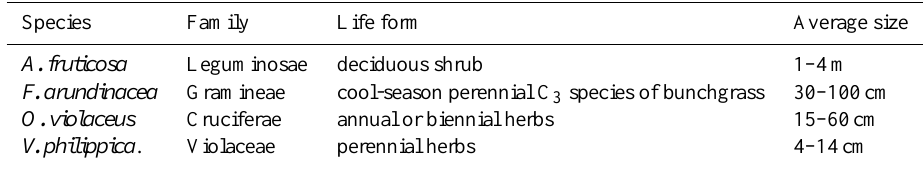
Table 2. Characteristics of target species.